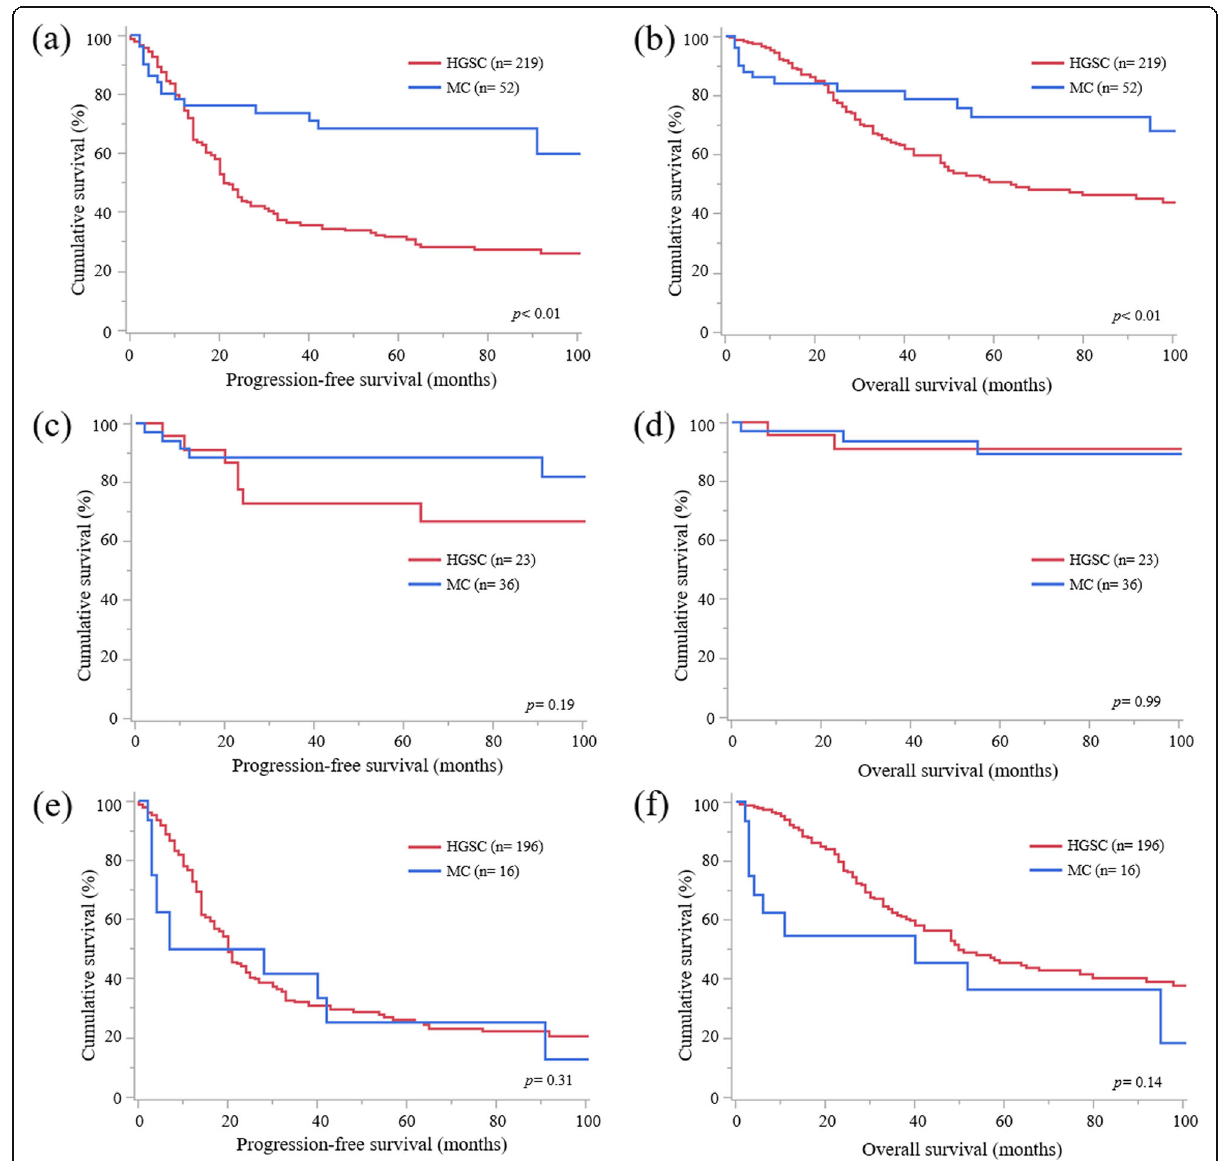
Fig. 2 Survival analysis of mucinous carcinoma and high-grade serous carcinoma. A Progression-free survival (PFS) curves of all cases of mucinous carcinoma (MC) and high-grade serous carcinoma (HGSC). HGSC has a worse prognosis than MC ( p < 0.01). B overall survival (OS) curves of